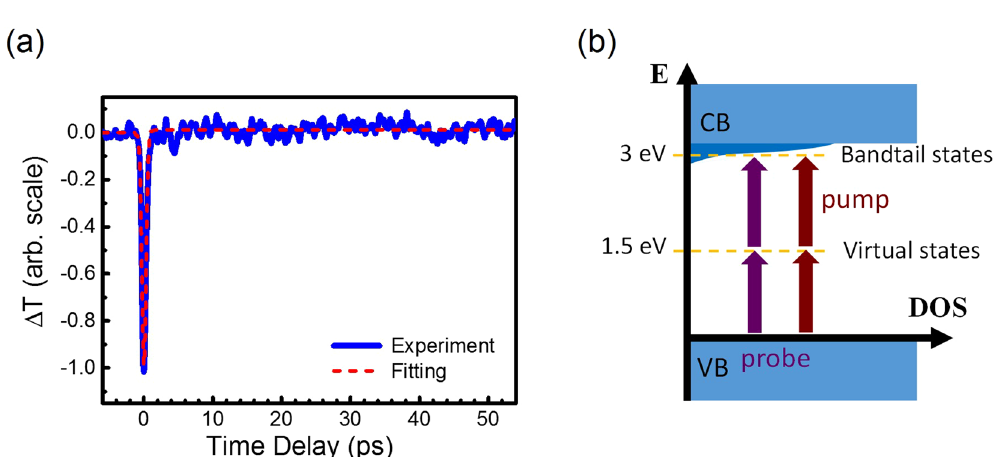
Figure 2. ( a ) The transient transmission changes of the probe pulses through the un-doped GaN. The pump/ probe wavelength (photon energy) is 820 nm (1.5 eV). ( b ) The schematic diagram illustrates the density of states in un-doped GaN. Since there is no state at 1.5 eV in un-doped GaN, the transient response in ( a ) is associated with carrier dynamics in the bandtail states monitored by the two-photon transition of the 1.5 eV probe